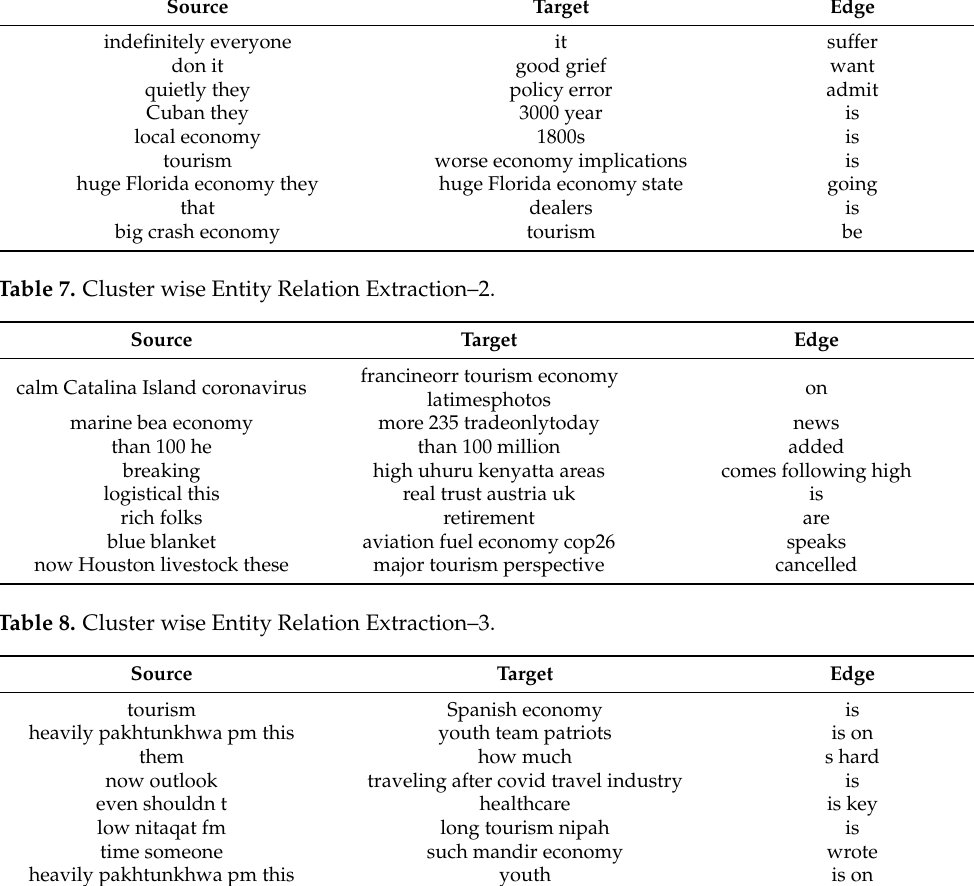
Table 6. Cluster wise Entity Relation Extraction–1.